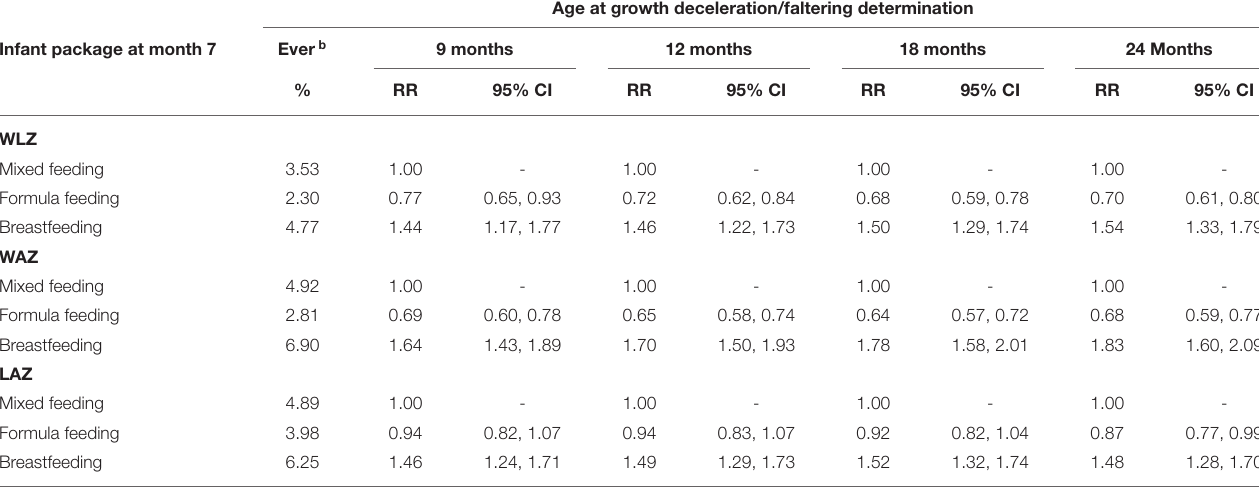
Age at growth deceleration/faltering determination